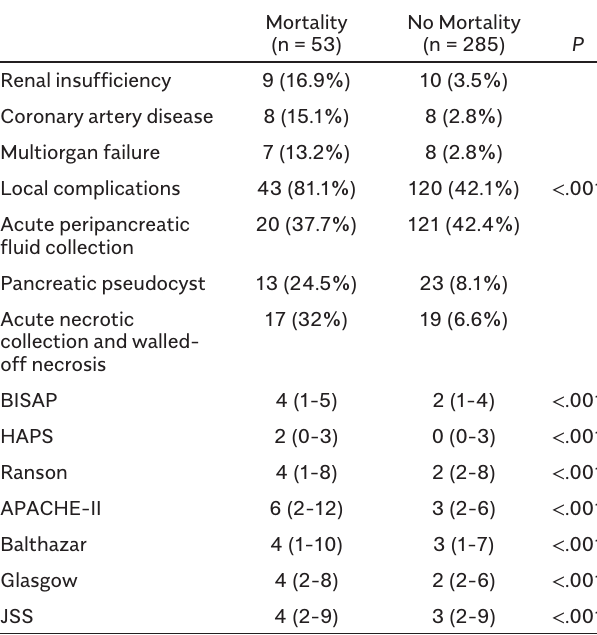
Table 2. Differences Between Patients aged 65-80 Years with and without Mortality